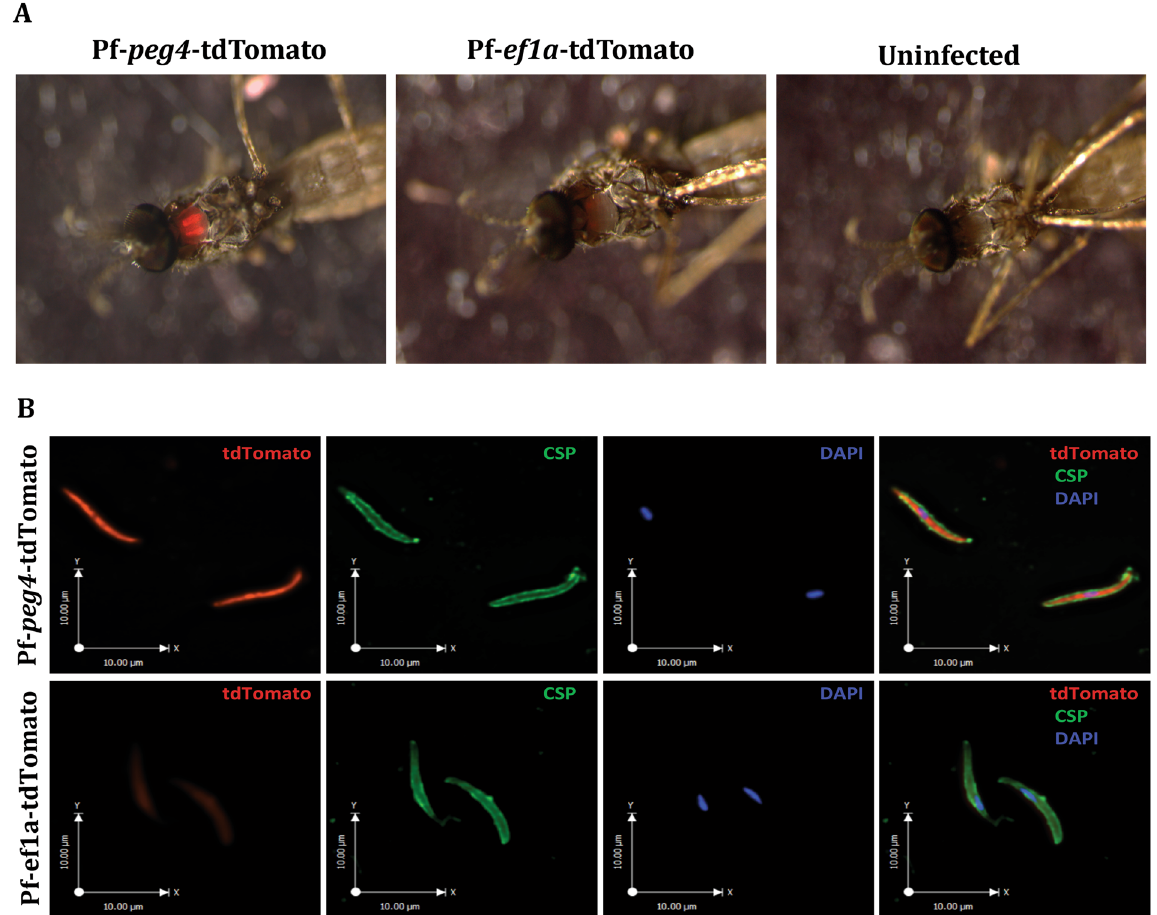
Figure 3. Immunofluorescence of sporozoites of P . falciparum -tdTomato lines. ( A ) The thorax of mosquitoes infected with the Pf- ef1 α -tdTomato or Pf- peg4 -tdTomato lines was visualized under a fluorescence stereoscope to detect the presence of the tdTomato sporozoites in the salivary glands. Note the red fluorescence observed in the thorax of mosquitoes infected with the P . falciparum -tdTomato lines compared to the absence of fluoresce in the uninfected mosquito. ( B ) Salivary gland sporozoites from mosquitoes infected with the Pf- ef1 α -tdTomato or Pf- peg4 -tdTomato were fixed and stained with an anti-PfCSP antibody (green) and analyzed by fluorescence microscopy to detect the cytoplasmic tdTomato (red) and the surface CSP (green). DNA was stained with DAPI (blue). Note the more intense signal detected from Pf- peg4 -tdTomato sporozoites as compared to Pf- ef1 α - tdTomato sporozoites, which match the fluorescence intensities from panel